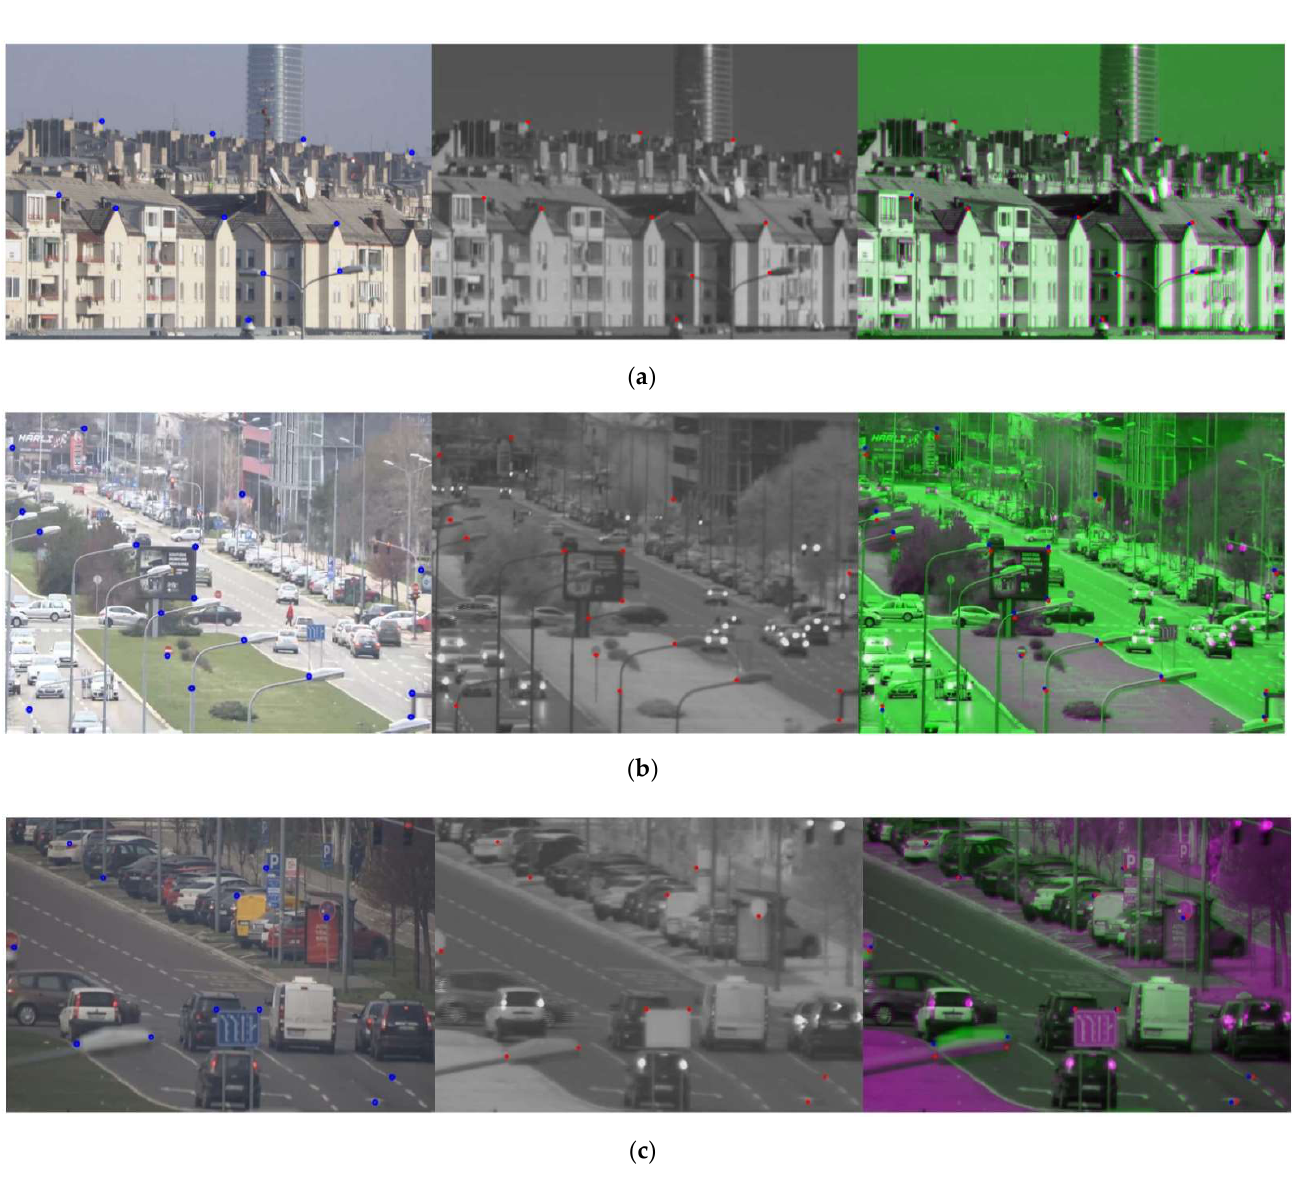
Figure 6. Visible-light image, SWIR image and fused image of the scene taken with: ( a ) the least common FOV of 6.127 deg, the distance to the nearest object in the image is 420 m, and to the farthest is 2650 m; ( b ) FOV of 6.32 deg, the distance to the nearest object in the image is 280 m, and to the farthest is 1735 m; ( c ) FOV of 1.67 deg, the distance to the nearest object (street lamp) in the image is 255 m, and to the farthest is 810 m.